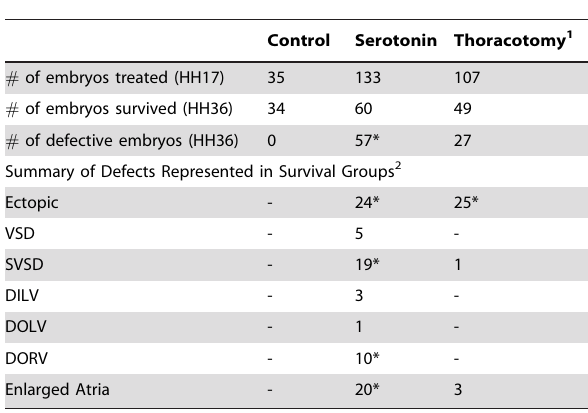
Table 1. Cardiac Defect Summary of in ovo 5-HT